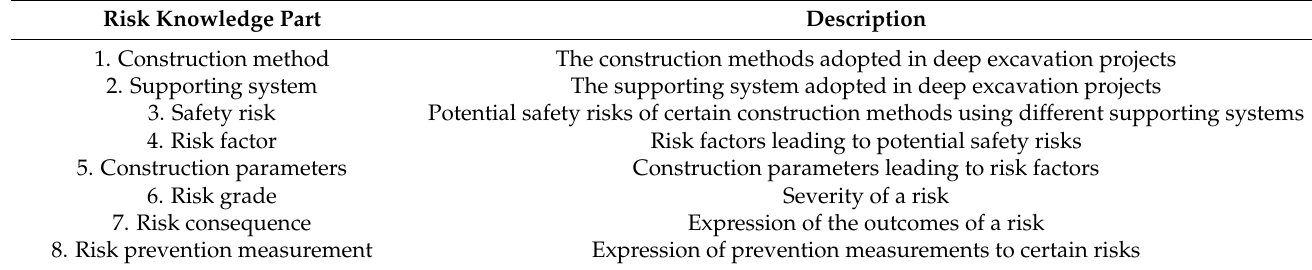
Table 4. Main risk knowledge parts in the fact